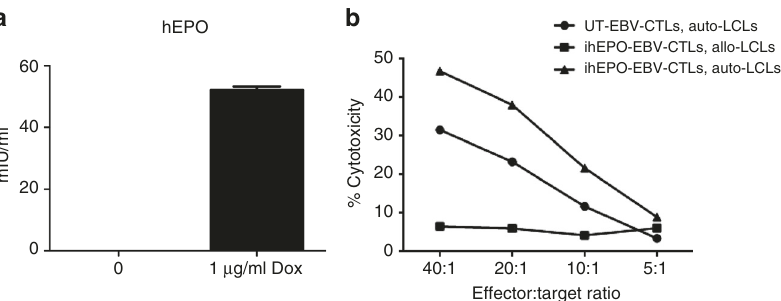
Fig. 7 Modi fi ed EBV-speci fi c T lymphocytes produce EPO and retain target speci fi city. a Genome modi fi cation of EBV-CTLs with pT-tight-hEPO results in tight regulation of EPO expression ( N = 3 ± SEM). b pT-tight-hEPO-modi fi ed EBV-CTLs lyse target cells with similar ef fi ciency as unmodi fi ed